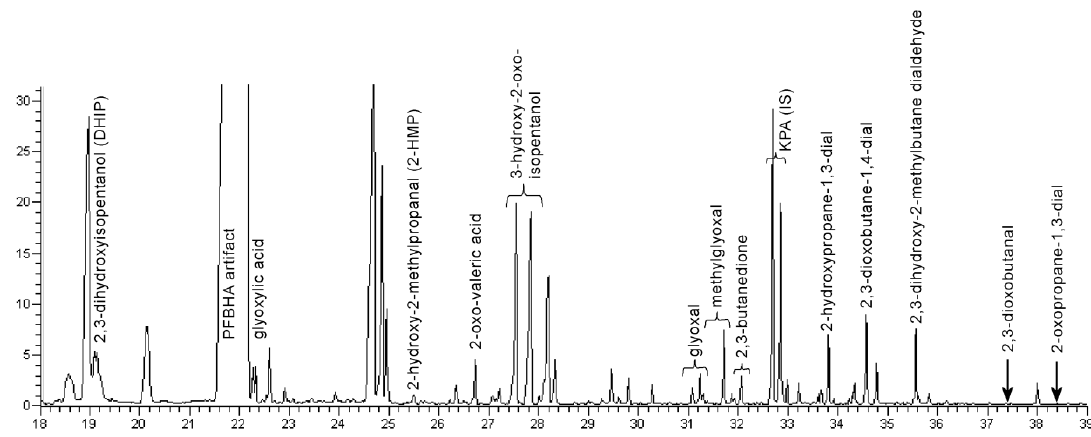
Fig. 2. GC-MS total ion chromatogram of organic extracts as PFBHA+BSTFA (gas phase) derivatives from an irradiated MBO.